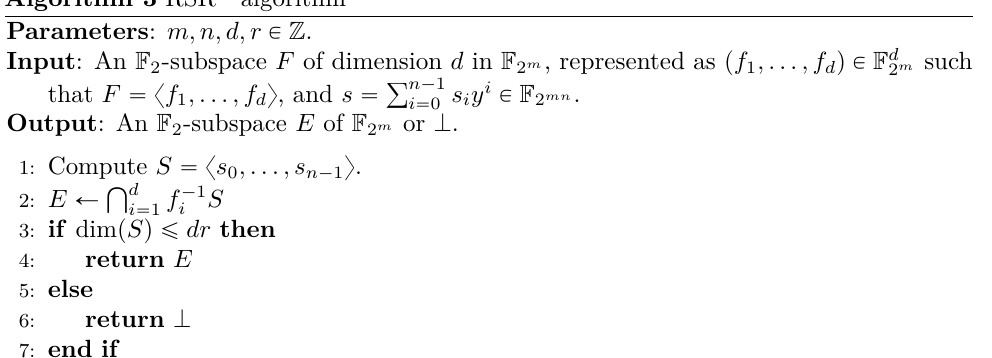
Algorithm 3 RSR `